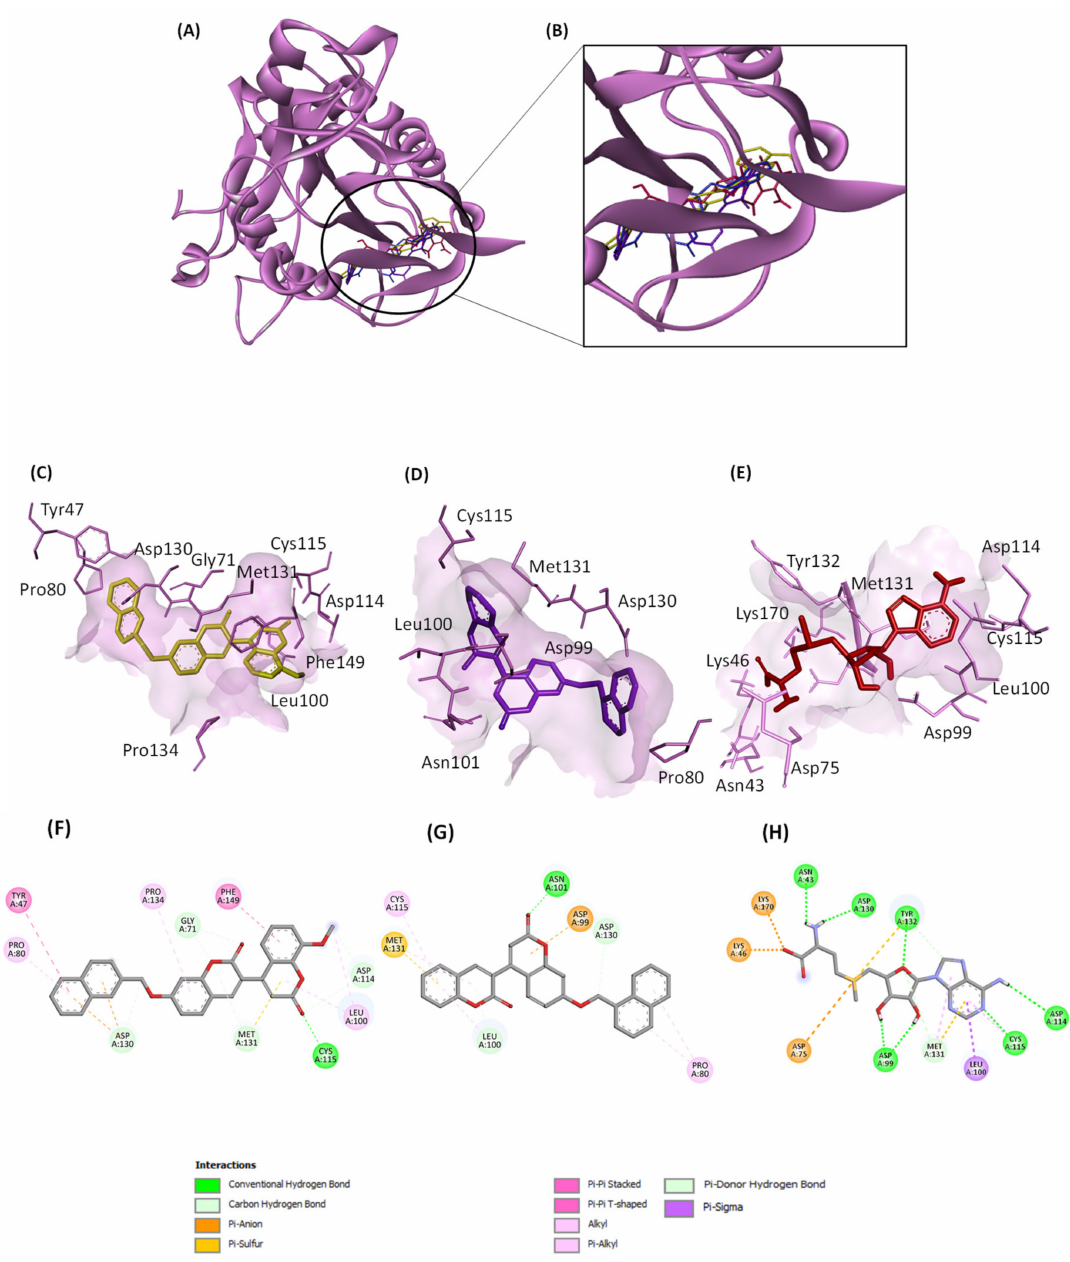
Figure 6. 3D and 2D views of the interactions of the hit molecules with SARS-CoV-1 nsp16 binding pocket (PDB: 3R24) determined by molecular docking. ( A ) Binding of the hits and the control SAM. ( B ) Zoomed view of the 3D structure of SARS-CoV-1 nsp16. ( C – E ): interactions of the amino acids in the binding pocket with ZINC12880820 (gold), ZINC2129028 (purple), and the control SAM (red), respectively. ( F – H ) are 2D views of ( C – E ), respectively. The images were generated by Discovery Studio